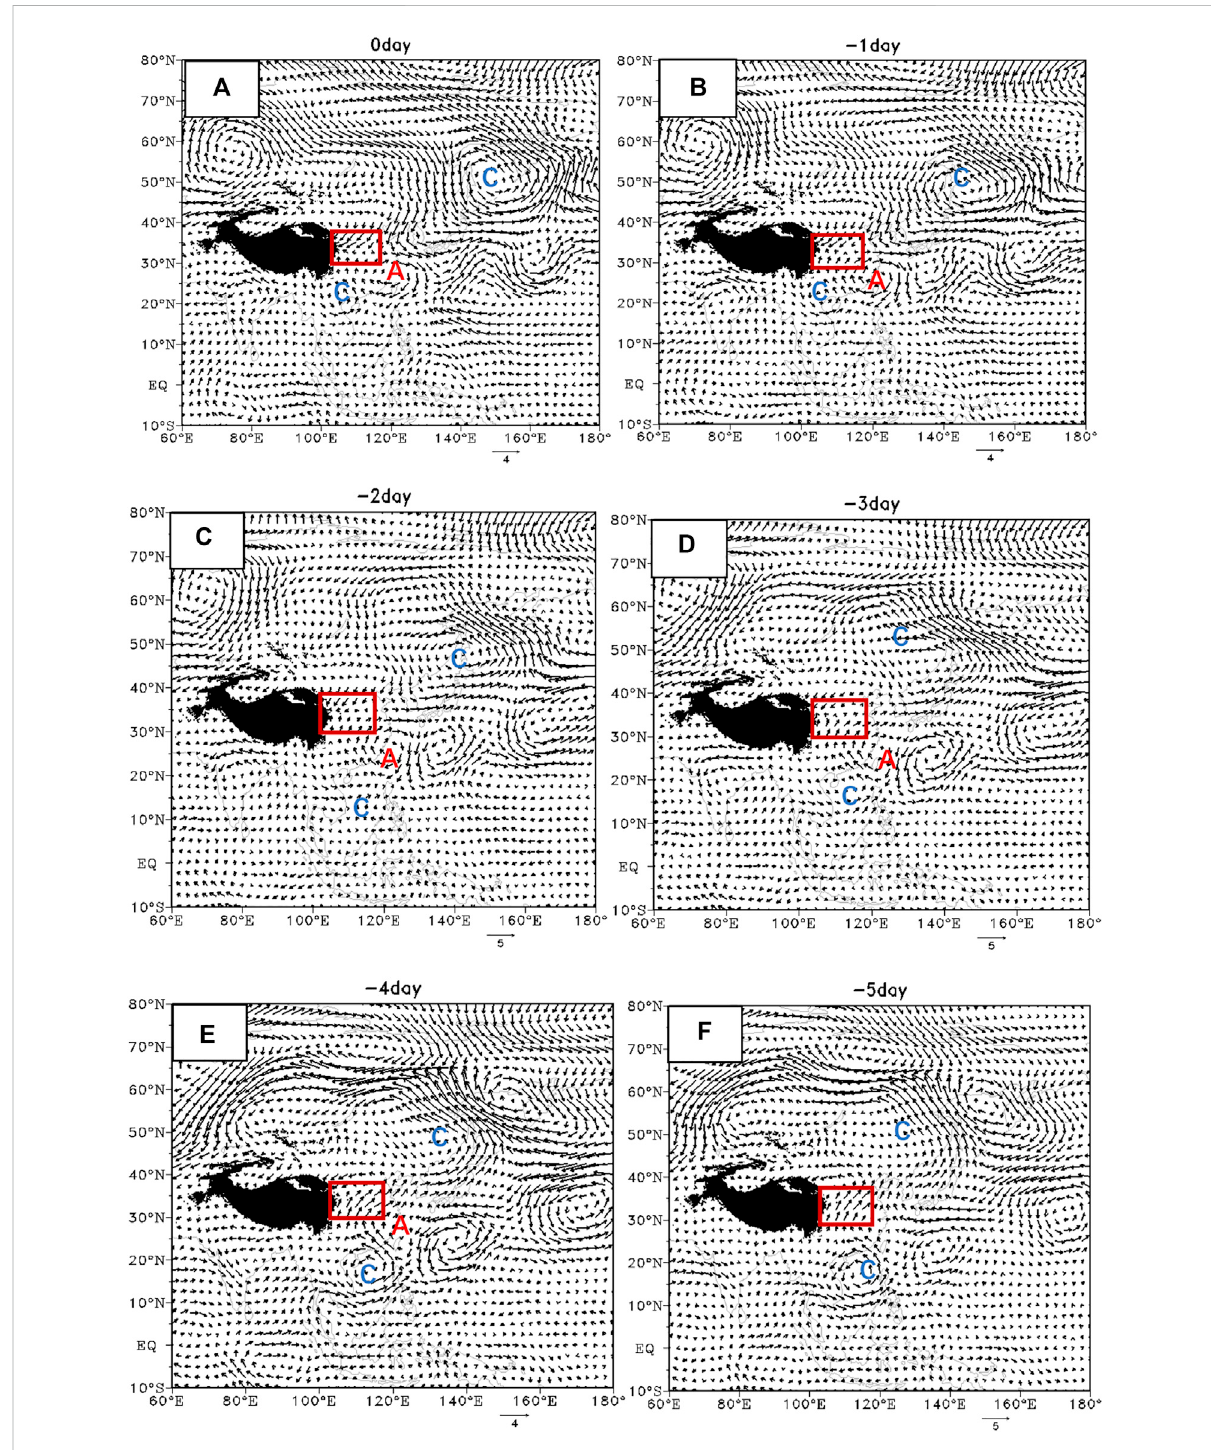
FIGURE 3 Evolution ofthe low-frequency(15 – 30 days) wind fi elds at850 hPa from 5 days before theprecipitation to 0 dayafter onset inBasin area, unit: